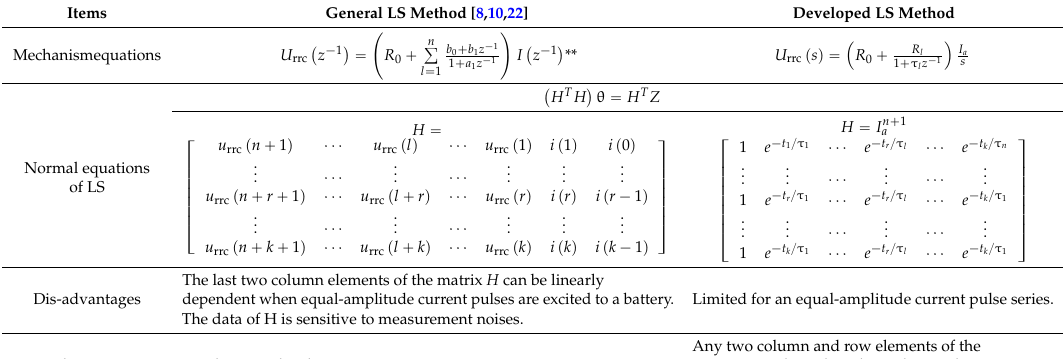
Table 1. Comparison of normal equations between the general LS and developed LS methods.